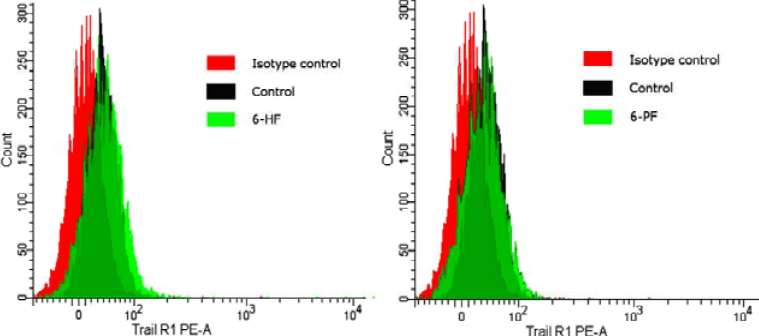
Figure 4. Effects of synthetic flavanones on death receptor expression in HeLa cancer cells. Cells were incubated for 48 h with 6-HF or 6-PF at the concentration of 50 μ M. The surface expression of ( A ) TRAIL-R1 and ( B ) TRAIL-R2 on cancer cell was analysed by flow cytometry. The values represent mean ± SD of three independent experiments performed in